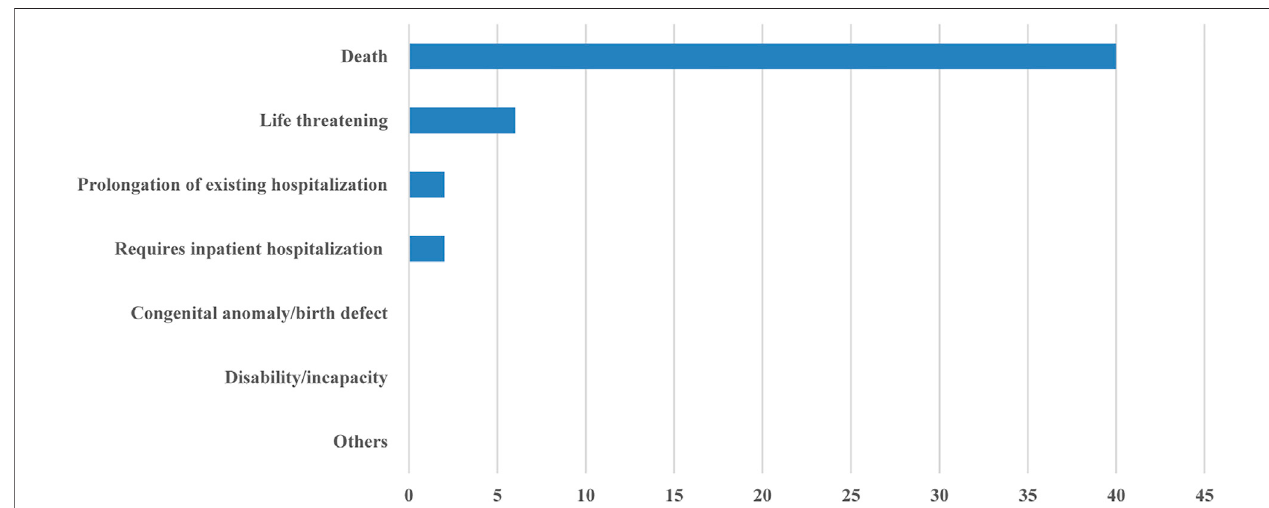
FIGURE 2 | Number of publications reported the outcomes of SAEs.